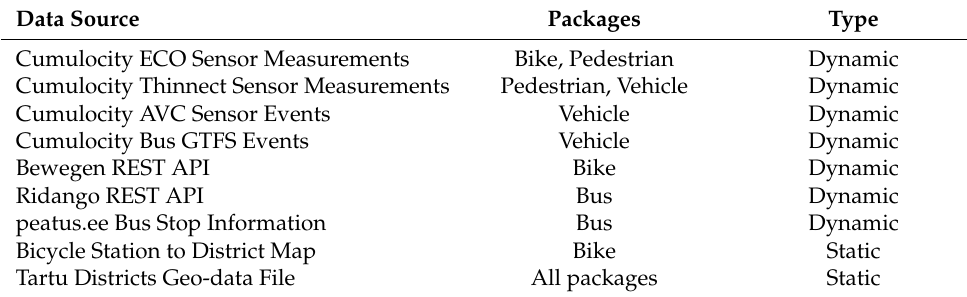
Table 1. Data sources of the Modal Split